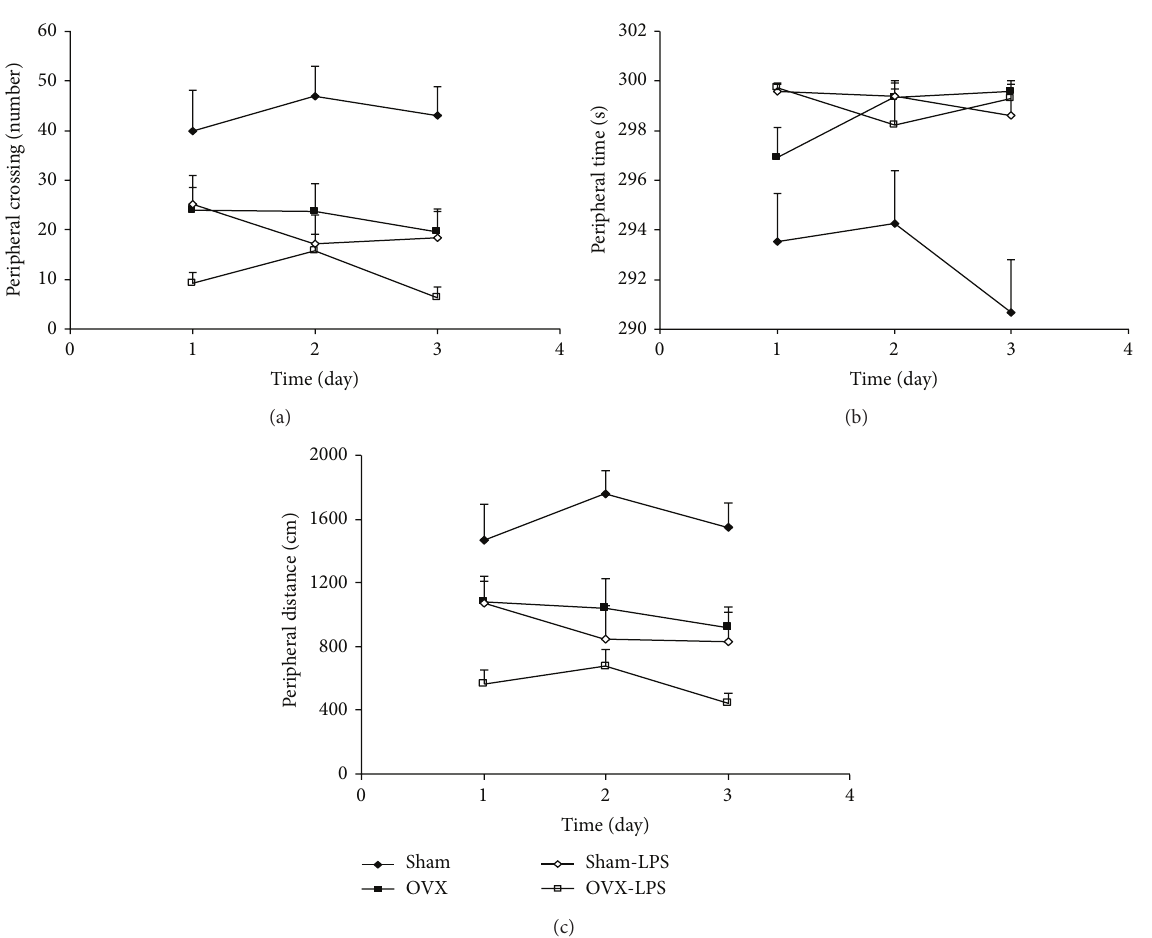
Figure 3: Comparison of peripheral crossing number (a), the time spent in peripheral zone (b), and the traveled distance in peripheral zone (c) in the open field test between four groups. Data are expressed as mean ± SEM ( 𝑛 = 10 in each group). The number of crossing, the time spent, and the traveled distance in the peripheral zone in the OVX and Sham-LPS group groups were lower than that of the Sham group ( 𝑃 < 0.01 – 𝑃 < 0.001 ). The peripheral crossing number by the animals of OVX-LPS group was not different than that of OVX group. There was also no significant differences between OVX-LPS and OVX group in the time spent in peripheral zone and peripheral crossing number; however, the traveled distance in the peripheral zone by the animals of OVX-LPS group was lower than that of OVX group ( 𝑃 < 0.05